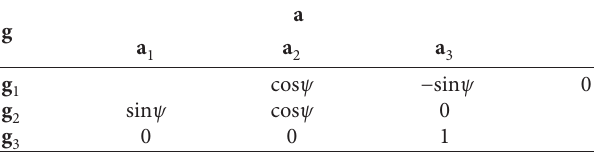
Table 2: Coordinate system transformation between g and a .